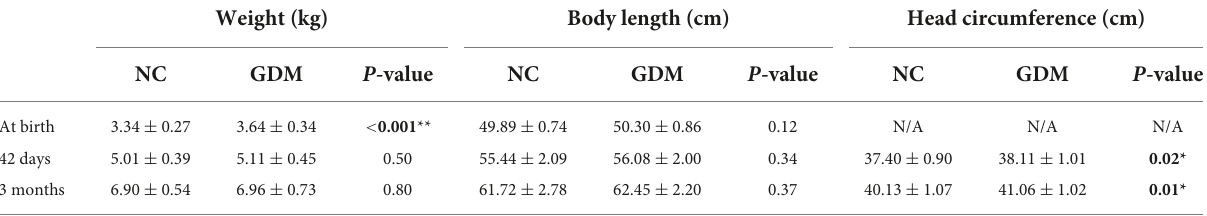
TABLE 2 Growth and development of infants born to mothers with or without GDM. Weight (kg) Body length (cm) Head circumference (cm) NC GDM P -value NC GDM P -value NC GDM P